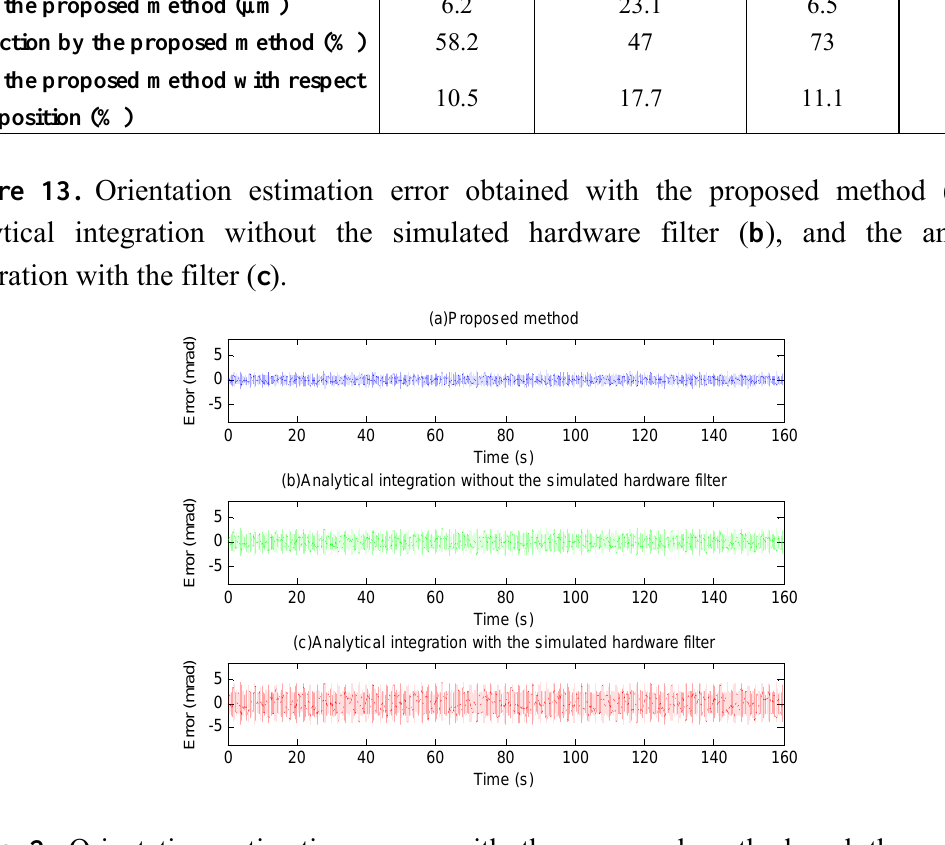
Table 2. Orientation estimation errors with the proposed method and the analytical integration method with and without the simulated hardware